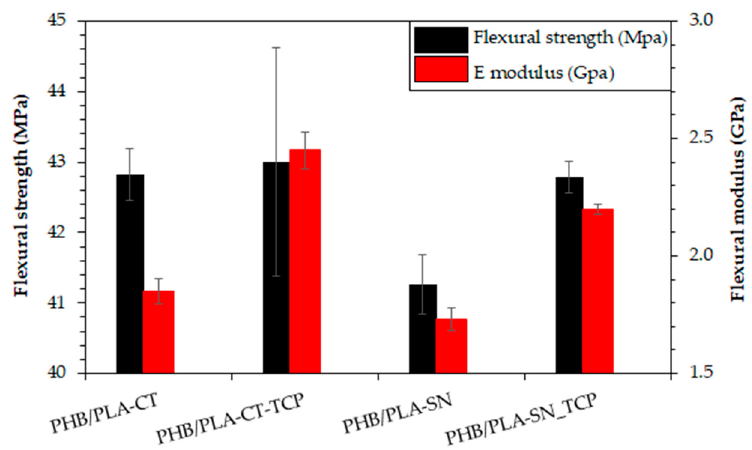
Figure 3. The results of flexural test of 3D printed specimen.